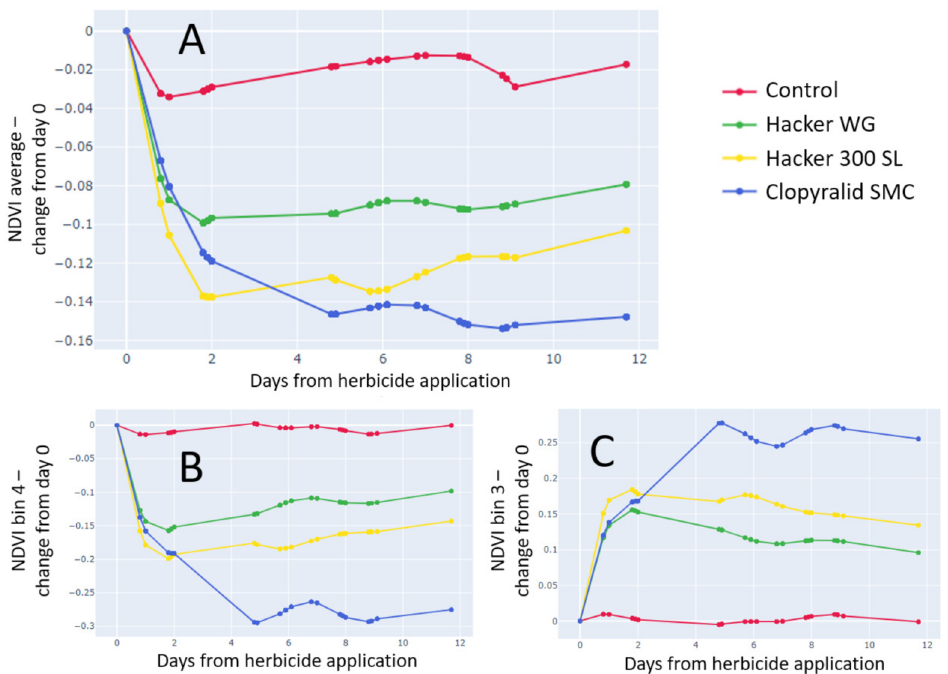
Figure 7. Dynamics of changes in NDVI (normalized differential vegetation index) of cocklebur treated with various herbicides and Control plants. ( A ) Average NDVI of the plants after subtraction of the initial values at the time of the herbicide treatment. ( B ) Fraction of leaves with NDVI in the range 0.5–1 (“bin 4”—leaves with good chlorophyll content) after subtraction of the initial values at the time of the herbicide treatment. ( C ) Fraction of leaves with NDVI in the range 0–0.5 (“bin 3”—leaves with low chlorophyll content) after subtraction of the initial values at the time of the herbicide